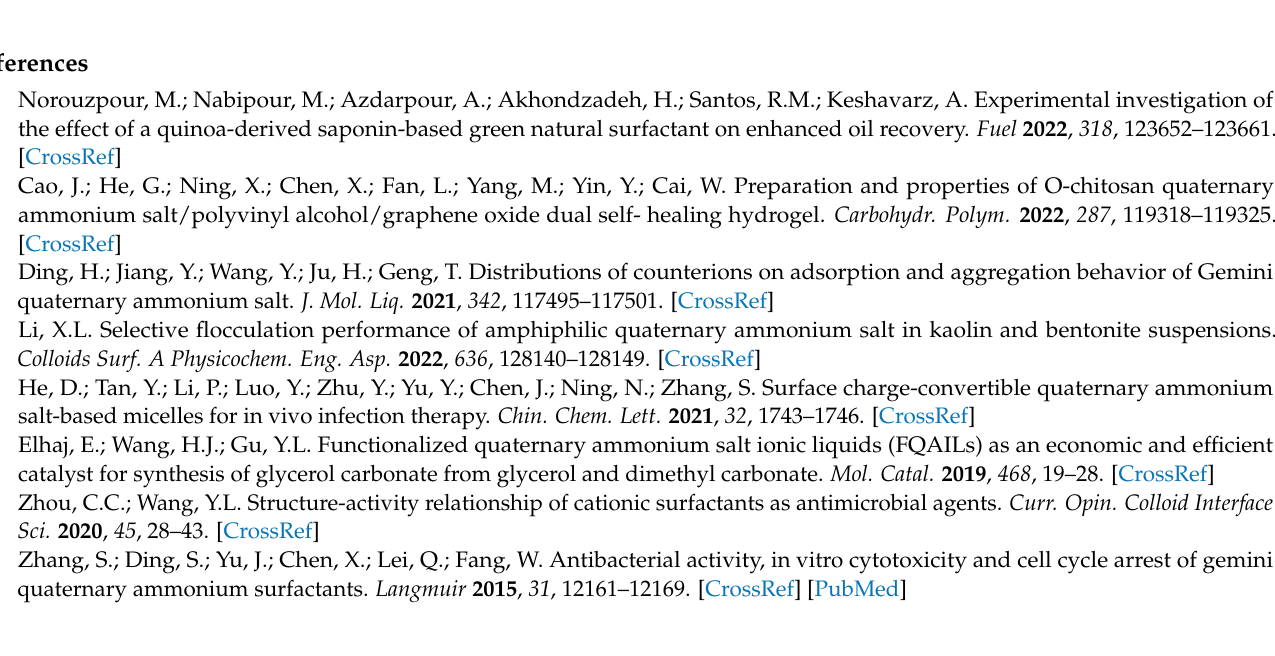
(f) C 16 DDGPB comparative IR spectra; Figure S3: 1 H-NMR spectrum of DDGPD; Figure S4: 13 C-NMR spectrum of DDGPD; Figure S5: 1 H-NMR spectrum of C 8 DDGPB; Figure S6: 13 C-NMR spectrum of C 8 DDGPB; Figure S7: 1 H-NMR spectrum of C 10 DDGPB; Figure S8: 13 C-NMR spectrum of C 10 DDGPB; Figure S9: 1 H-NMR spectrum of C 12 DDGPB; Figure S10: 13 C-NMR spectrum of C 12 DDGPB; Figure S11: 1 H-NMR spectrum of C 13 C-NMR spectrum of C 1 H-NMR 14 DDGPB; Figure S12: 14 DDGPB; Figure S13: spectrum of C 16 DDGPB; Figure S14: 13 C-NMR spectrum of C 16